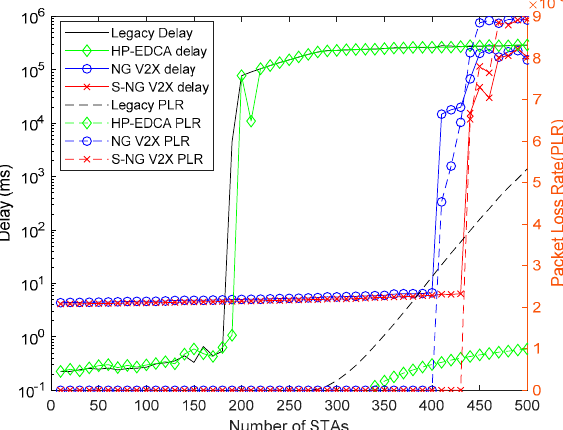
Figure 15. Average delay and PLR comparison for legacy, High Priority EDCA, proposed NG-V2X, proposed Scheduled NG-V2X channel access.